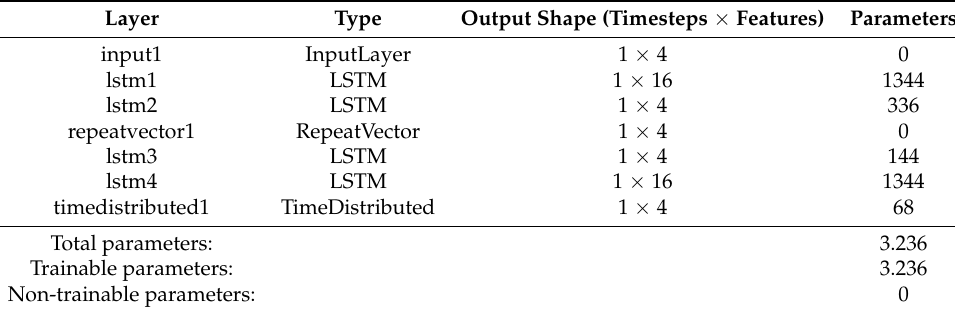
Table 2. Number of trainable parameters.